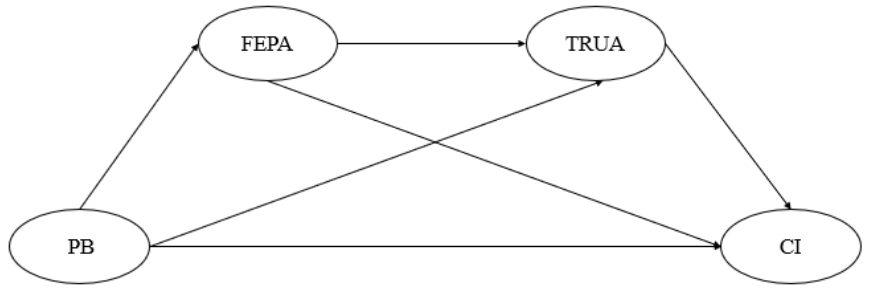
Figure 1. The theoretical model in this paper. Note: PB = Perceived Benefit; FEPA = Forest Environmental Protection Attitude; TRUA = Tourism Resources Utilization Attitude; CI = Consumption Intention. Hypothesis 1: Forest tourists’ perceived benefits exert a positive impact on consumption intention. Hypothesis 2: Tourists’ perceived benefit exerts a positive impact on attitude toward forest envi- ronmental protection